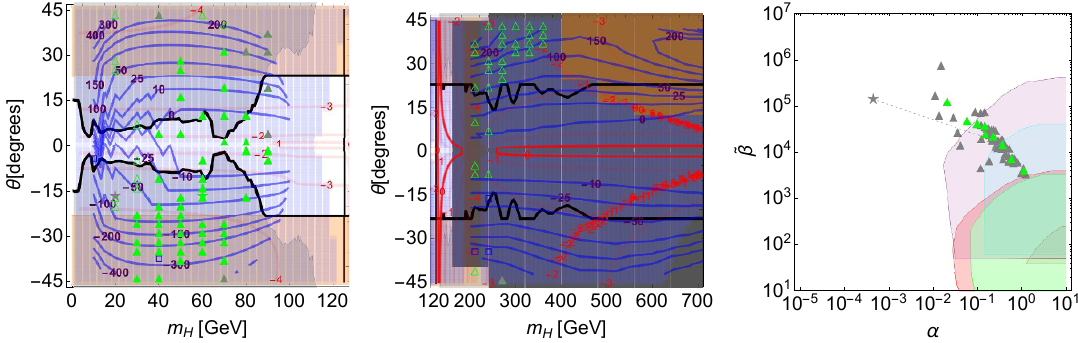
Figure 5 . Types of multi-step PT for m X = 100 GeV, g X = 2 ( v S = 50 GeV). See the captions of figures 3–4.